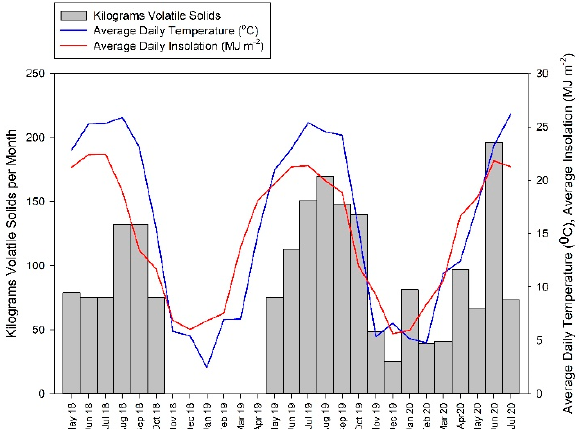
Figure 1. Amounts of volatile solids fed per month to each of the digesters, with average daily temperature and average daily insolation received for each month of the study.